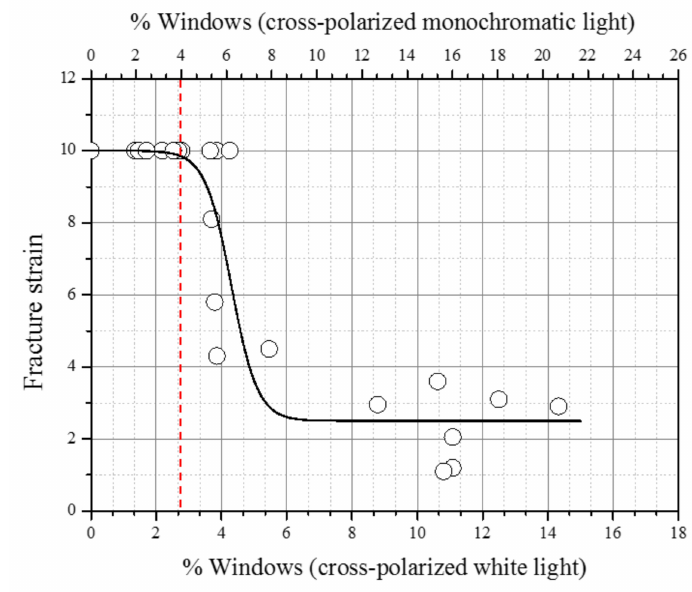
Figure 16. Fracture strain versus % windows of specimens from all sectors.